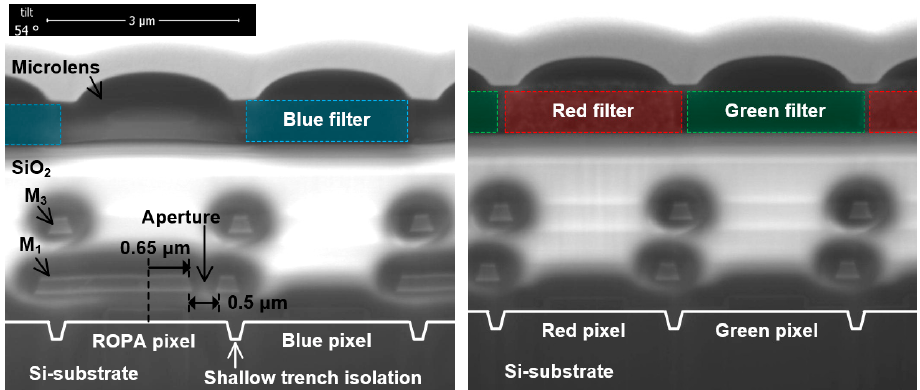
Figure 7. Structures of the fabricated pixels obtained by the scanning electron microscopy.